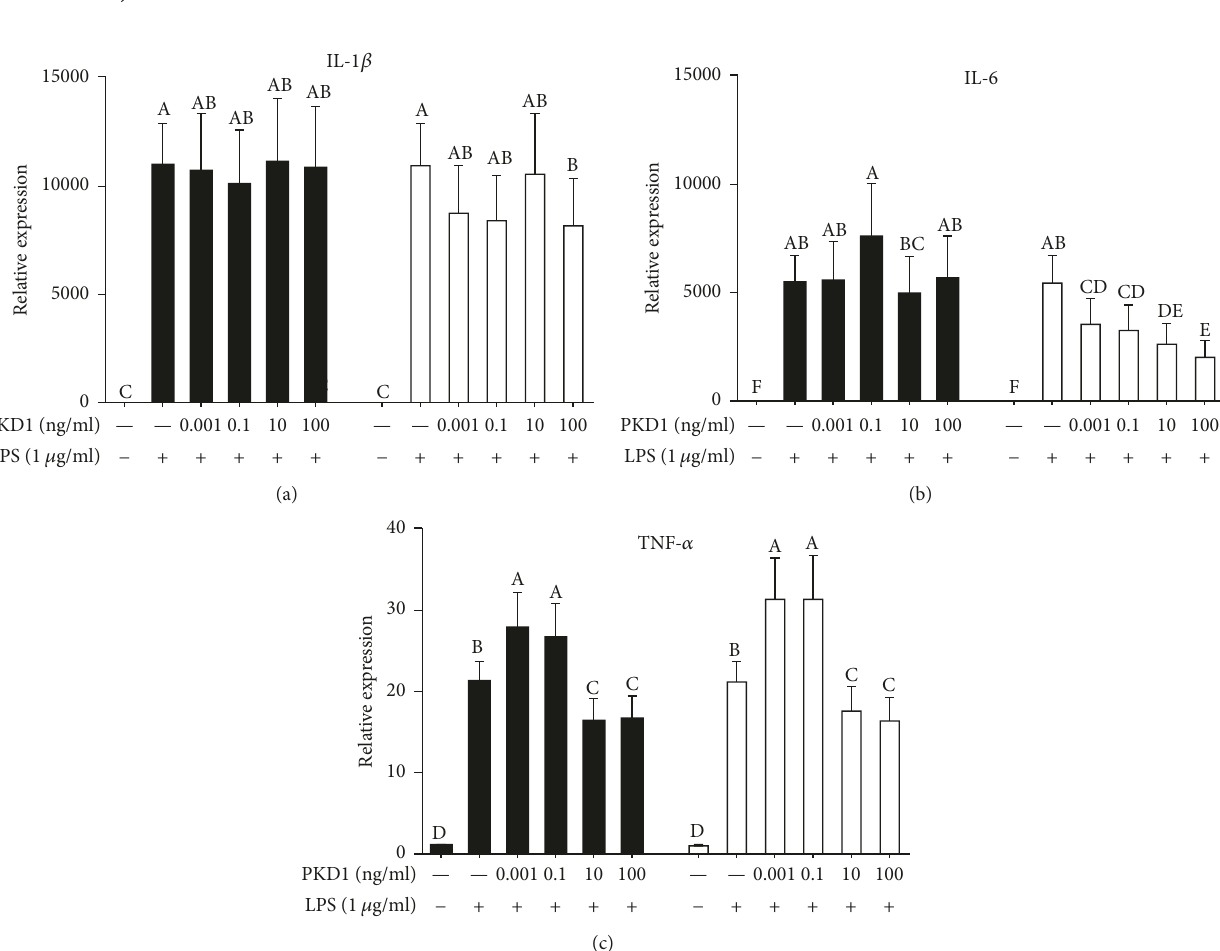
Figure 3: Effect of PKD1 on IL-1 𝛽 , IL-6, and TNF- 𝛼 mRNA expression in RAW264.7 cells. Protein kinase D1 (PKD1; 0.001, 0.1, 10, 100ng/ml) was administered apically to Caco-2 cells in co-culture with RAW264.7 cells. An inflammatory response was induced in RAW264.7 cells with 1 𝜇 g/ml lipopolysaccharide (LPS, E. coli : O127). Effects of PKD1 on IL-1 𝛽 , IL-6, and TNF- 𝛼 expression levels were evaluated in two different situations: ( ◼ ) LPS was administered to RAW264.7 cells for 3 h, followed by PKD1 to Caco-2 cells for 3 h to investigate whether PKD1 can ameliorate an already established inflammation. ( ◻ ) PKD1 was administered to Caco-2 cells for 3 h at which point RAW264.7 cells were stimulated with LPS for 6 h to evaluate whether PKD1 can suppress inflammation initiation. Data are presented as mean transcriptional levels relative to the negative control (0% FCS, unstimulated) with 95% confidence intervals ( 𝑛 = 3 ). Significant differences ( 𝑃 < 0.05 ) within concentrations of PKD1 and LPS are indicated by the uppercase